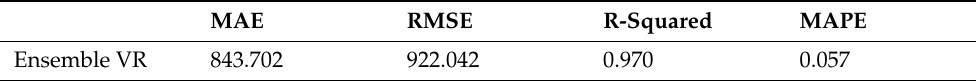
Table 5. Performance assessment of the proposed model. MAE RMSE R-Squared MAPE Ensemble VR 843.702 922.042 0.970